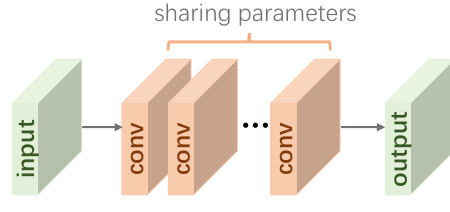
Figure 4. The structure of recursive learning.